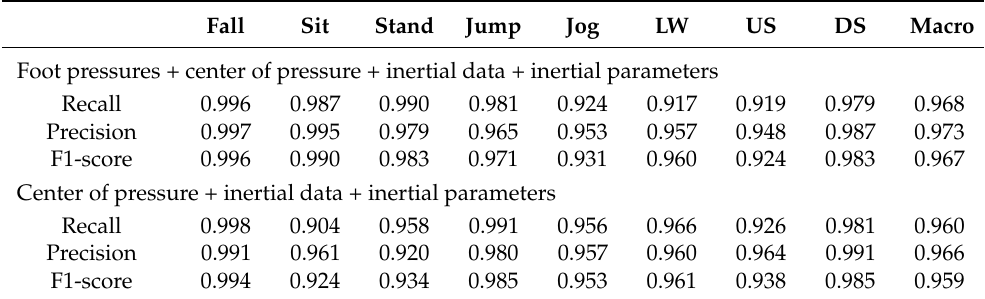
Table 6. Results on the detections of fall and physical activities based on Inertial data and parameters obtained from both feet. Fall Sit